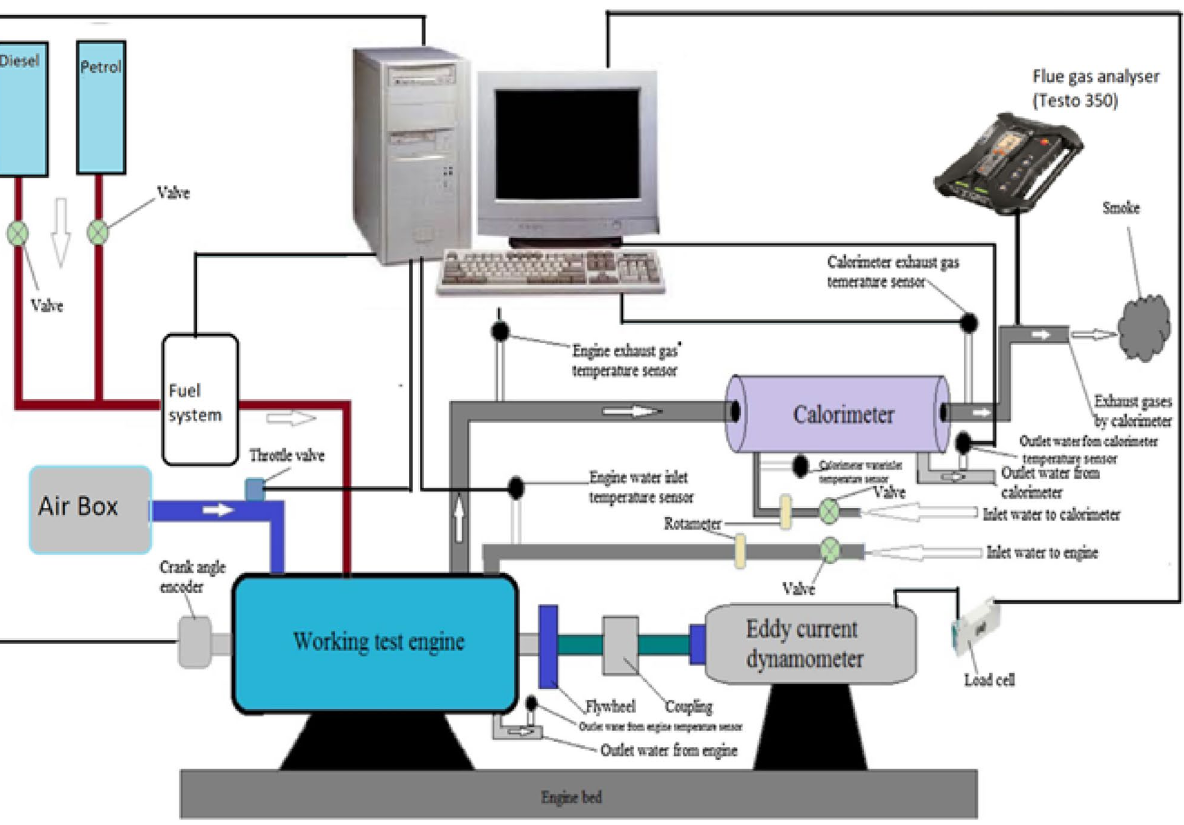
Figure 1. Experiemtal